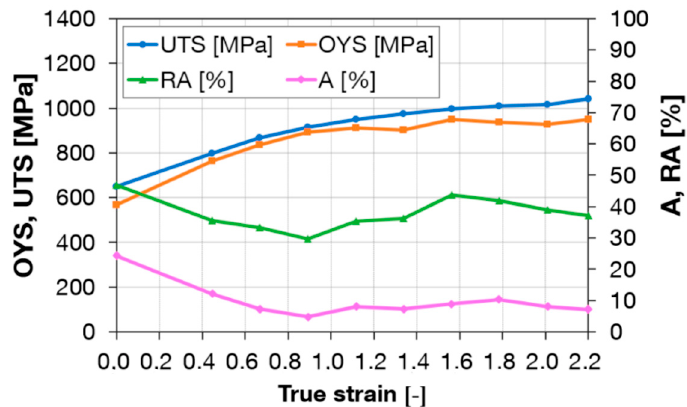
Figure 12. Tensile properties after rotary swaging in relation to true strain.